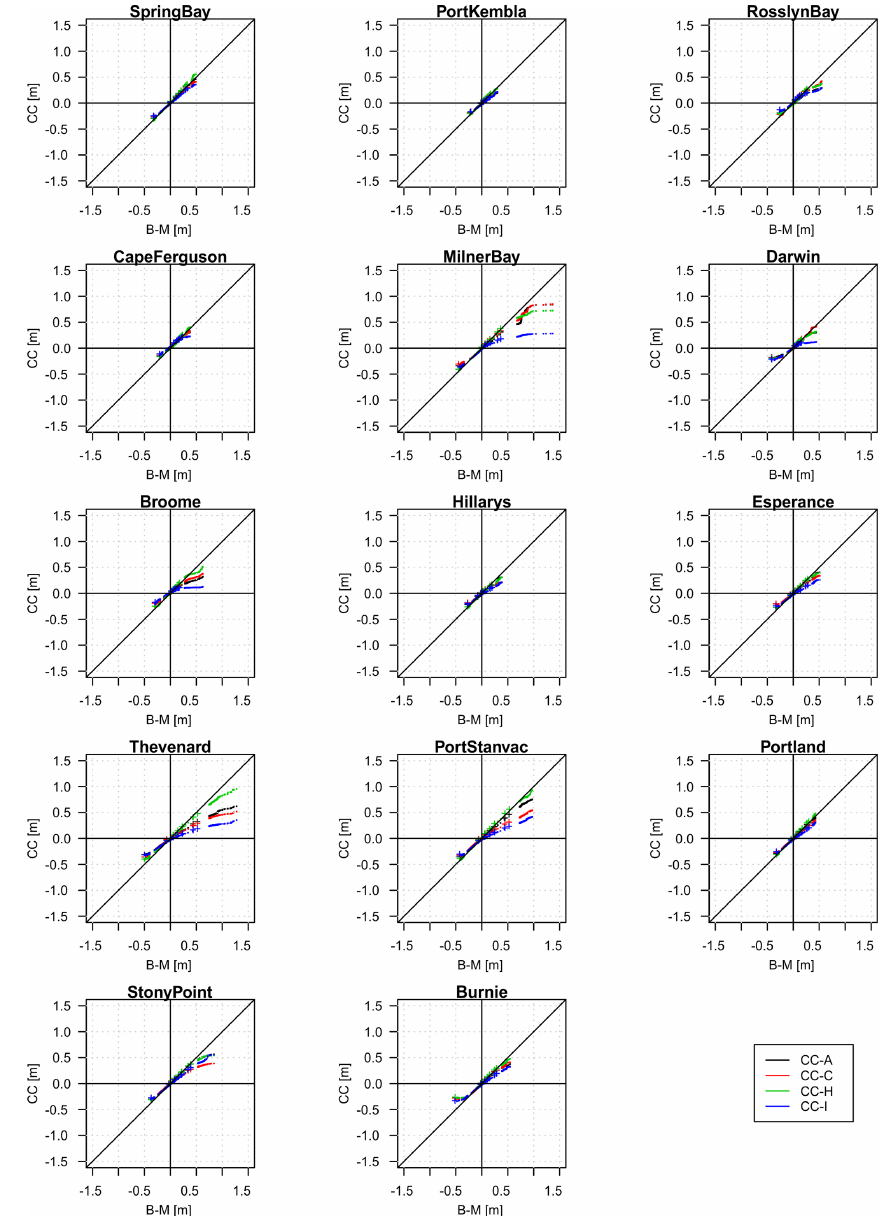
Figure 7. Quantile–quantile plots comparing the sea levels from the four 1980–1999 CC simulations versus the B-M simulation. Note that for clarity, only the “ + ” symbols are used to denote the 0.1, 1, 10, 50, 90, 99 and 99.9th